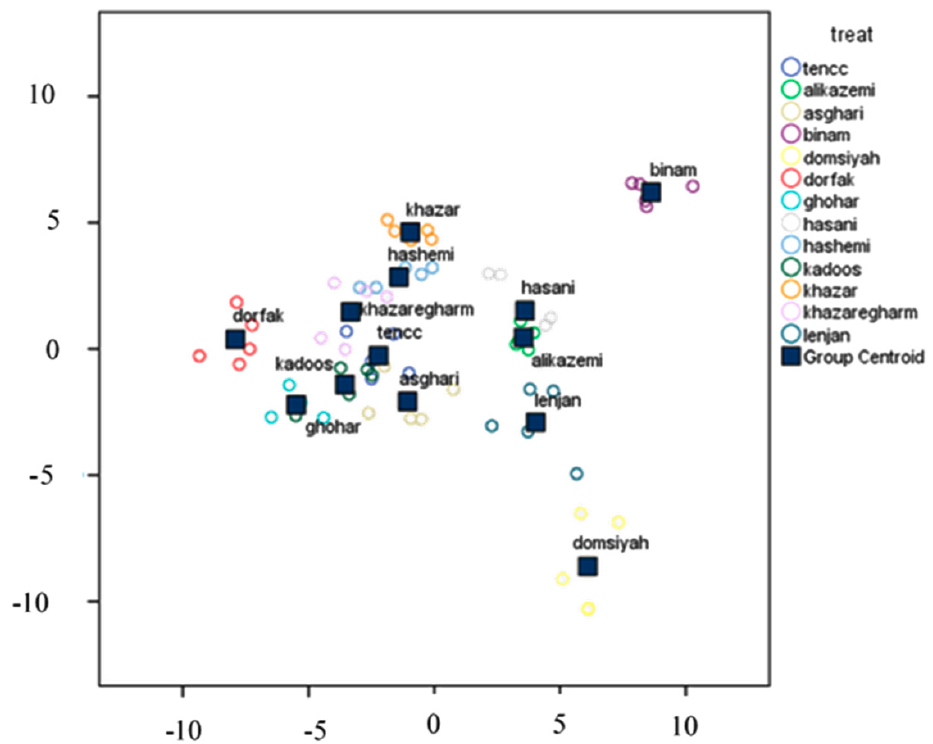
Figure 15. Classification of 13 cultivars. Brown rice.